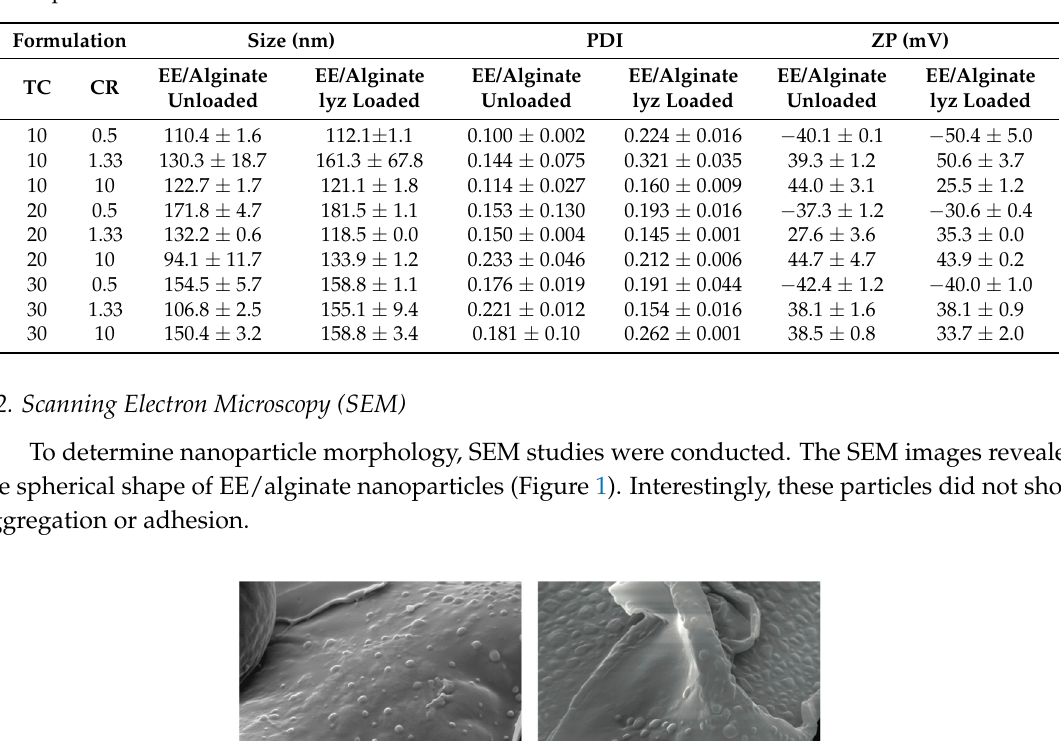
Table 1. Characteristics of the formulation, in terms of size, PDI, and zeta potential ( n = 3). Results are expressed as means ± standard deviations.